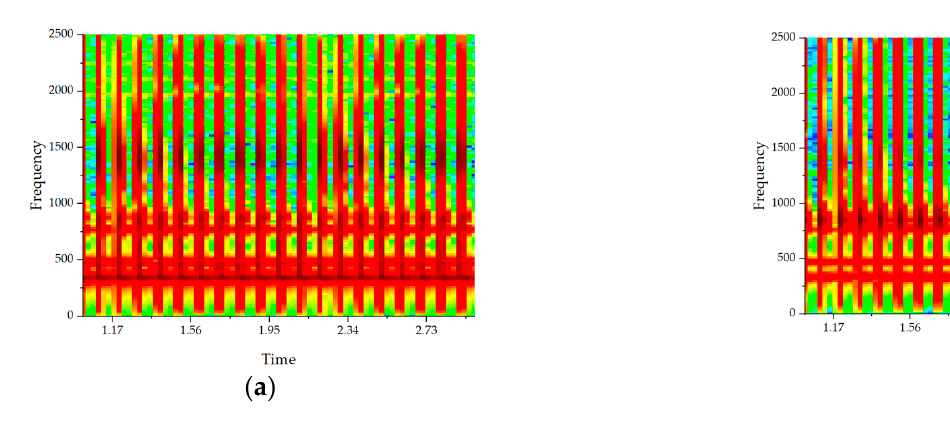
Figure 15. Acceleration response SFFT (Under random variable amplitude amplitude excitation);